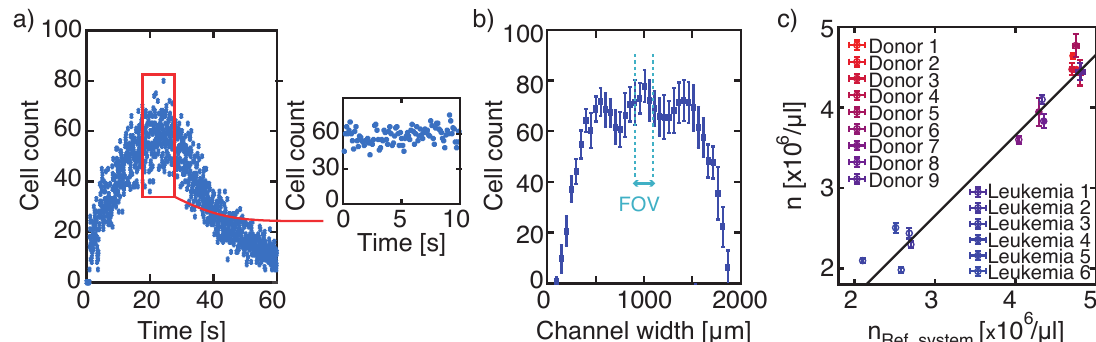
Figure 2. Laminar flow approach for cell counting. ( a ) Cell count per frame over 60s, where during a selected time period of 10s the cell count per frame is constant (red square and inlet). ( b ) Cell distribution along the channel width, where the dashed lines indicate the centre FOV for further cell concentration measurements. ( c ) Comparison of cell concentrations obtained from different donors measured with the reference system Siemens ADVIA 2120i to cell concentrations resulting from the laminar flow approach. To calculate the actual number of cells and the corresponding volume out of cells passing the FOV in a certain time period, time, channel width, and flow velocity are extrapolated. Variations in measurements were 2.47 ± 1.46% with an absolute deviation to the reference system of − 0.26 × 10 6 / µ